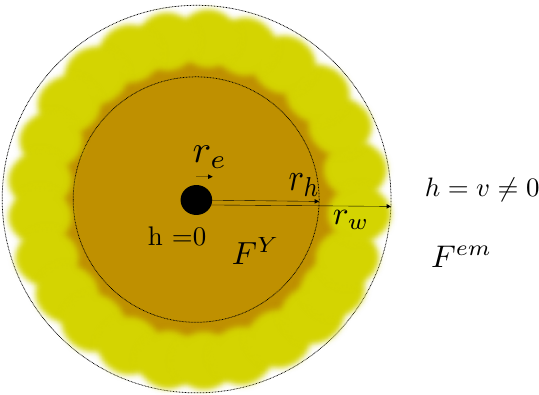
Figure 1 . Structure of a magnetic black hole for 1 (cid:28) Q (cid:28) Q ew . The black circle represents the near horizon region where the metric is very different from flat space. The brown region, r < r , h is where the electroweak symmetry is restored and where we have only weak hypercharge magnetic field. The yellow region, r , represents the electroweak “corona”. In this region we have h < r < r w nondiagonal SU(2) gauge fields and a varying higgs field. Further away, r > r , we have the w